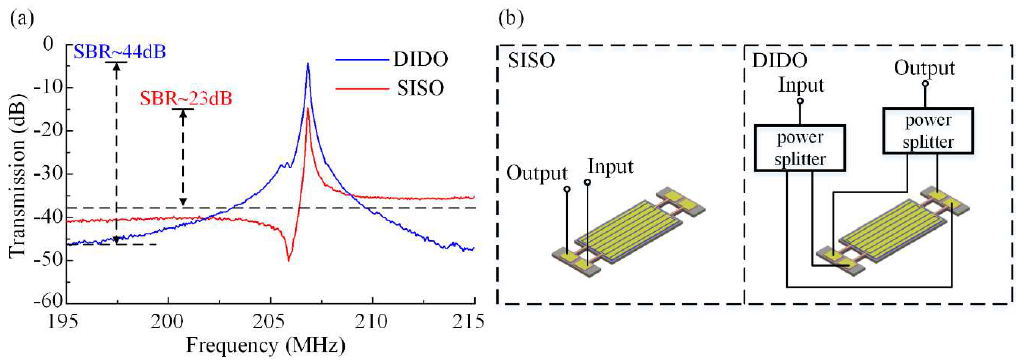
Figure 8. Measurements of S -parameters of the fabricated TPoS resonators in di ff erential configurations. ( a ) The measured response of the single terminal in single terminal out setup (SISO) is shown as the red trace, and the blue trace is the transmission plot for the DIDO setup. A resonant peak with high signal to background ratio (SBR) is achieved by the DIDO setup. The SBR of SISO is much lower than DIDO because of no cancellation of the common-mode feedthrough signal. The insert loss of the DIDO setup is much better than the SISO setup because this setup of DIDO can enhance the di ff erential-mode signal. ( b ) Measurement configurations of resonator operating in SISO and DIDO.